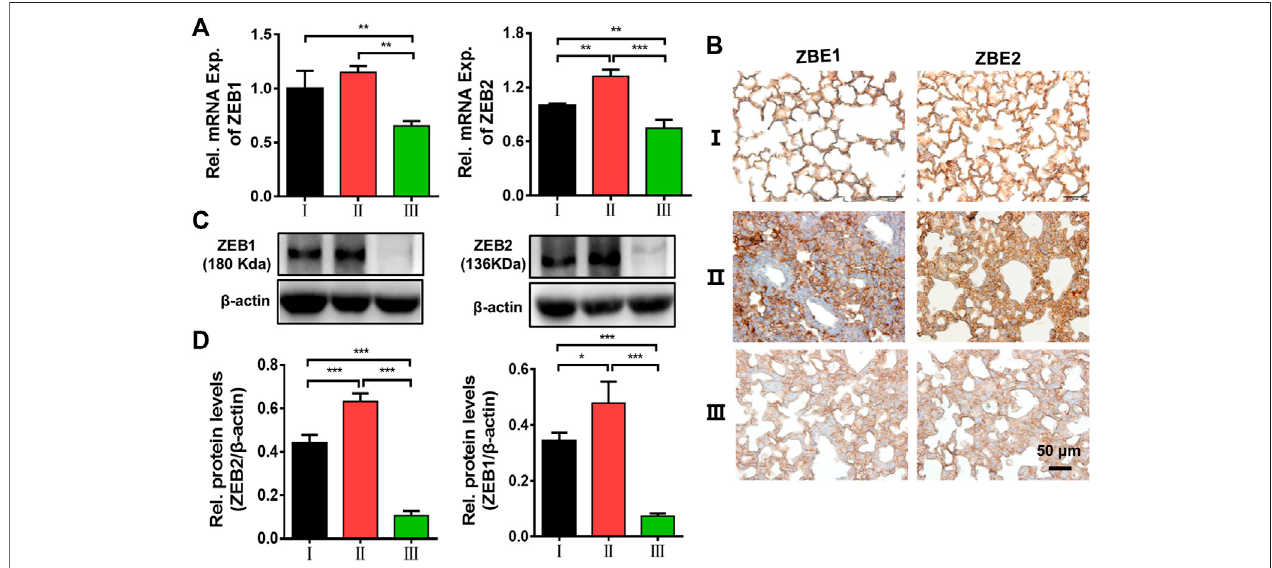
FIGURE 7 | Effects of ZEB1/2 silencing ability in vivo . (A) Immunohistochemical analysis expression of ZEB1/2 in mice lungs, (B) expression of ZEB1/2 were detected by quantitative RT-PCR, and (C,D) western blot analysis. (* p < 0.05, ** p < 0.01, *** p < 0.001). For each group: Ⅰ , Control; Ⅱ , LPS + Naked siZEB1/2; Ⅲ , LPS +